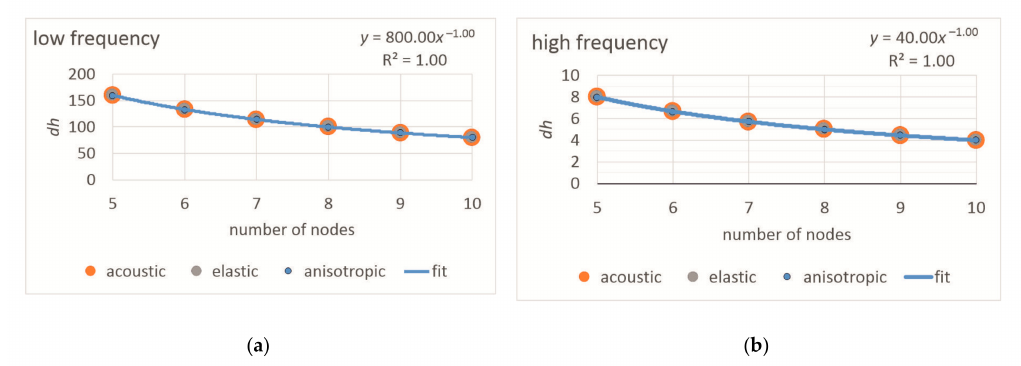
Figure 8. The relationships between the distance to the nearest calculation nodes dh (the largest allowable spatial modeling step) and the number of nodes per wavelength for: low ( a ) and high ( b ) frequencies of the source